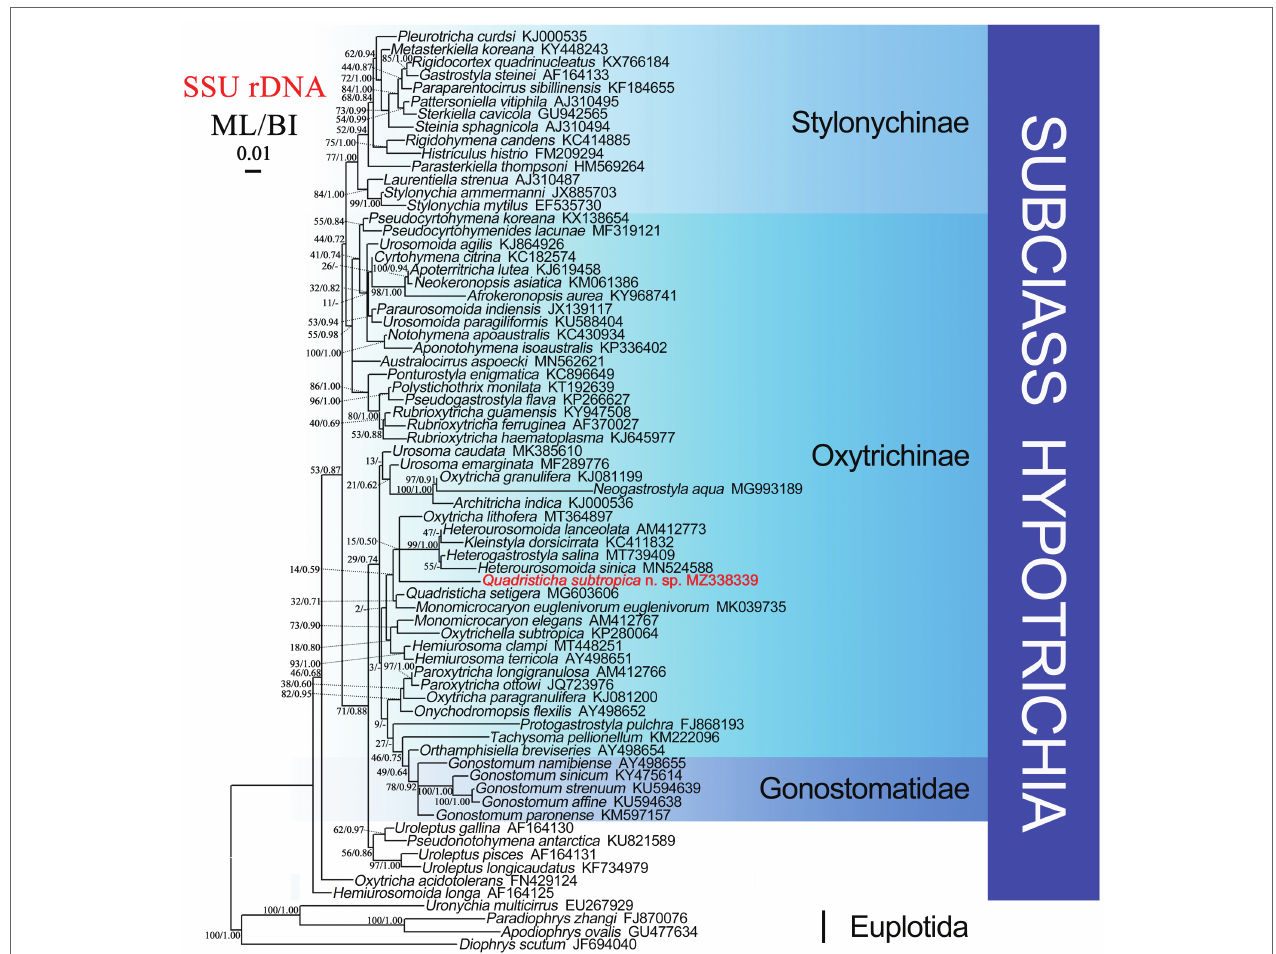
FIGURE 6 | Maximum likelihood (ML) tree based on SSU rDNA sequence data. Quadristicha subtropica n. sp. is indicated in bold. Support values for nodes are for ML and BI (ML/BI), respectively. Clades with a different topology in the BI tree are indicated by “-”. All branches are drawn to scale. The scale bar corresponds to 1 substitution per 100 nucleotide